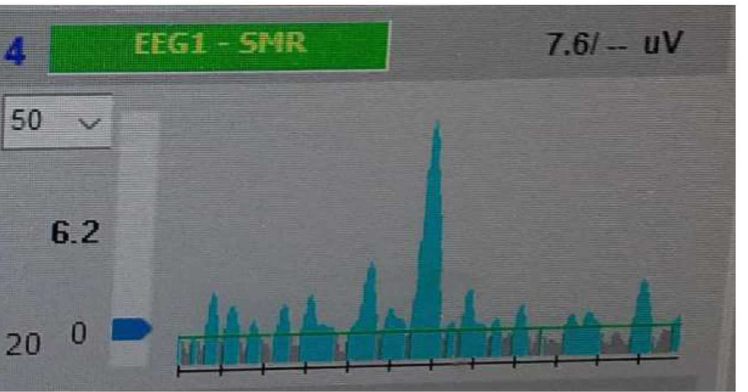
Fig 2. Principle of visual NFB feedback. Figure 2 depicts the underlying principle of NFB rewarding visual feedbacks. When NFB-rewarded selected EEG activity kept below reward threshold, online EEG graph was grey. As soon as amplitude of EEG activity was at least as high as reward threshold value, EEG graph got blue. Horizontal green line depicts reward threshold. Black line divided into 12 segments (each segment represents one second) (axis X) depicts time window. Axis y represents amplitude of EEG in pV (microvolt). Blue arrow in Y axis serves for manual adjustment of NFB reward threshold. 6.2 values next to axis Y (left side) indicates minimal value in pV which is necessary to be reached to get NFB feedback (blue EEG activity). 7.6 1.1V (the upper right quadrant indicates the average reward value within the current time window. 4 EEG1 -SMR is the title of this target online EEG graph predefined by NFB software Deymed Diagnostic (version